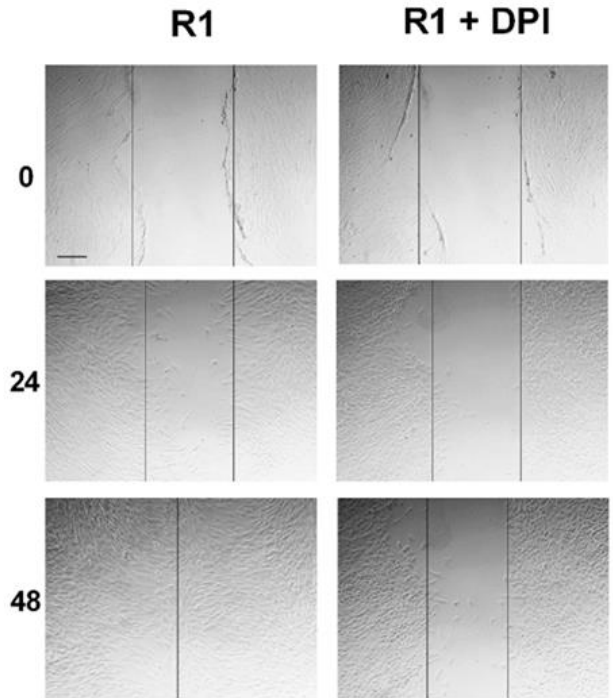
Figure 4. Effect of Nox inhibition on drug resistance and cell migration of primary melanoma cells. ( A ) Graph showing resistance test with MTT assay measured in primary melanoma cells (sensitive (S) or R1 or R1 + 0.1 µ M DPI) treated with vemurafenib from 0.1 up to 100 µ M for 3 days. **** p -value < 0.0001. ( B ) Graph showing migration assay, namely the area not invaded by cells, after 24 and 48 h. Representative images (scale bar = 100 µ m) of migration assay obtained with the scratch test measured in primary melanoma cells induced to resistance (R1) or R1 + 0.1 µ M DPI for 48 h. ◦◦ p -value < 0.01; *** p -value < 0.001; ****, ◦◦◦◦ p -value <